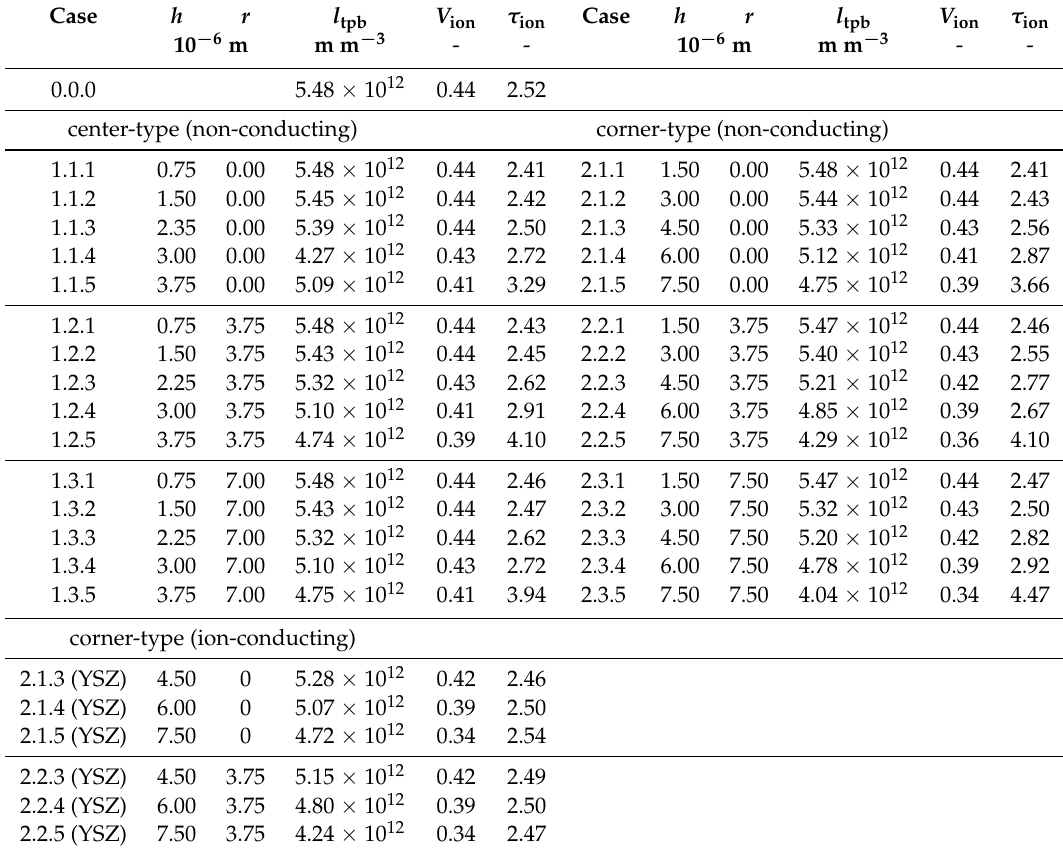
Table 2. Microstructure and disturbance parameters in the cases